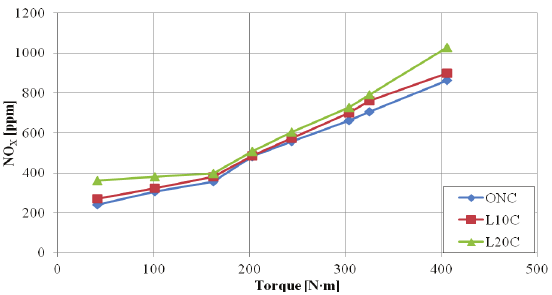
Fig. 5. PM for injection timing A and n = 1400 rpm